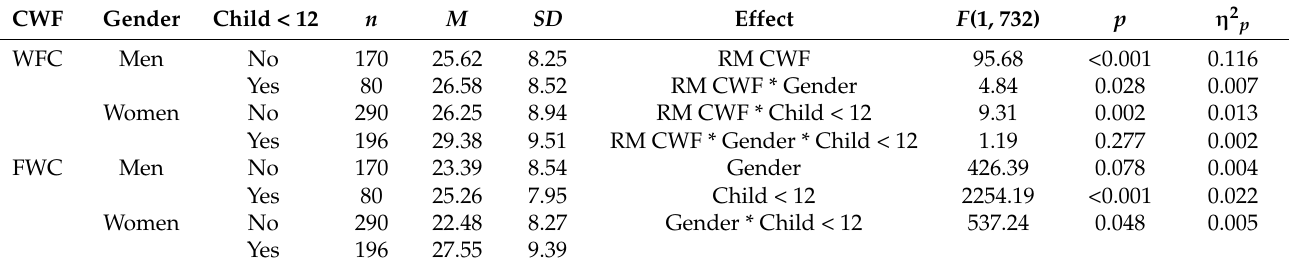
Table 1. A repeated measures two-way ANOVA for conflict work-family.